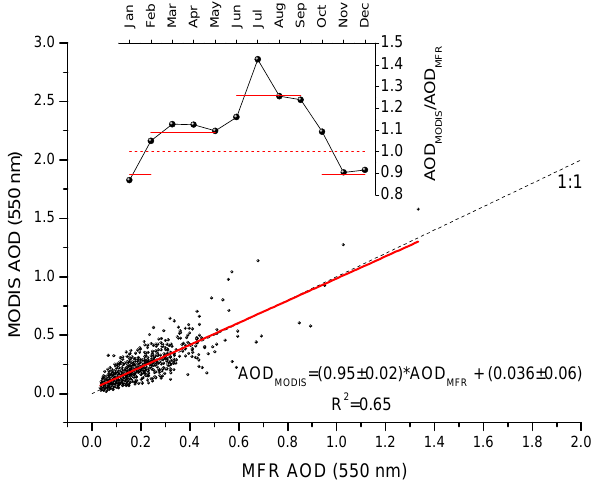
Fig. 8. Scatter plot between AODs from the MFR versus MODIS derived AODs over Athens. The red thick line is the regression line between the two data sets. The internal panel presents the annual cycle of the AOD MODIS /AOD MFR ratio, the red dashed line shows the unity value of the ratio, while the red thin lines corresponds to the average between months of close ratio values.